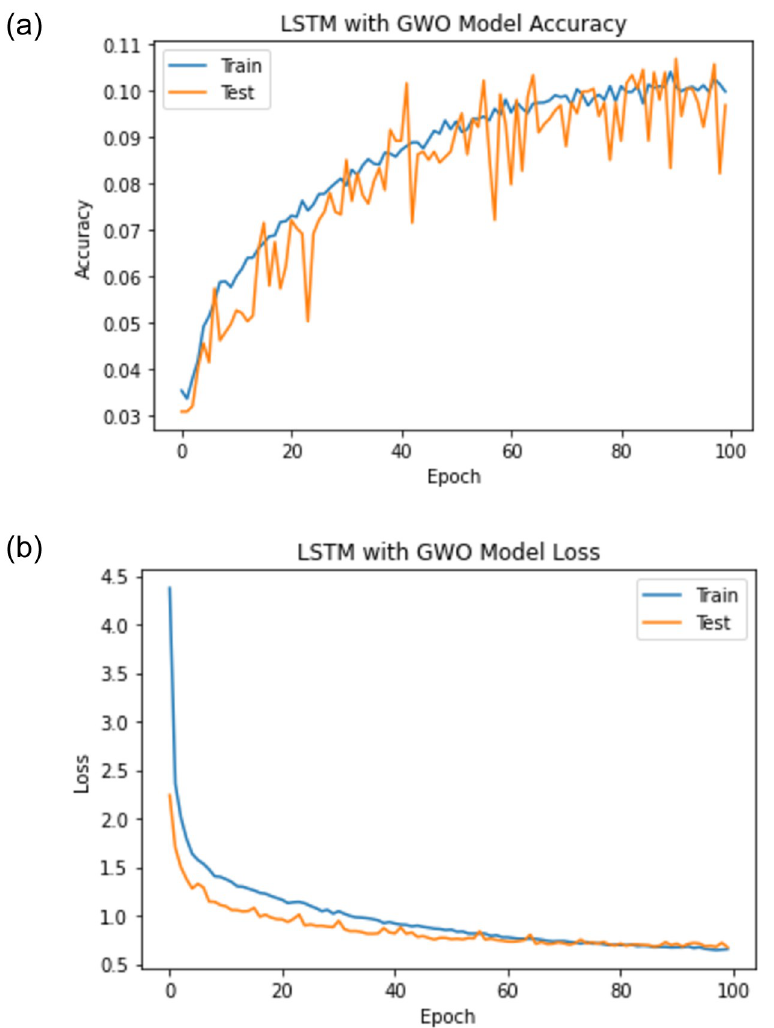
Fig 14. The LSTM-GWO accuracy and loss with experiment